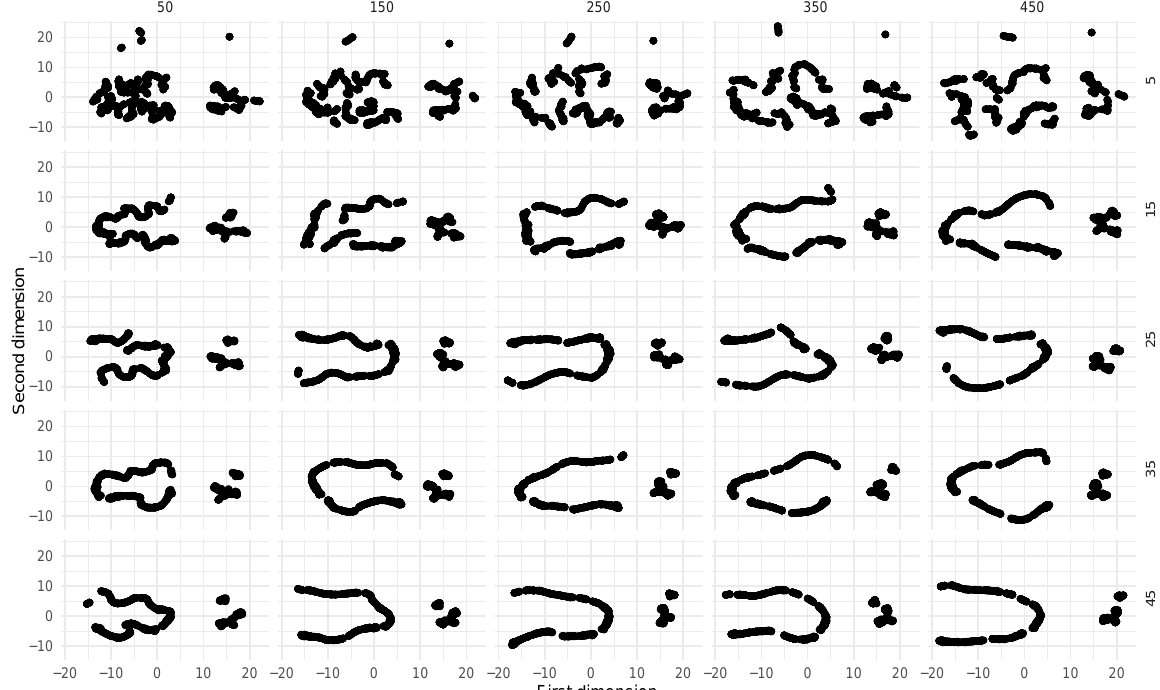
Fig. 1 Grid search of UMAP hyperparameters. Here, columns represent number of epochs, and rows represent neighborhood